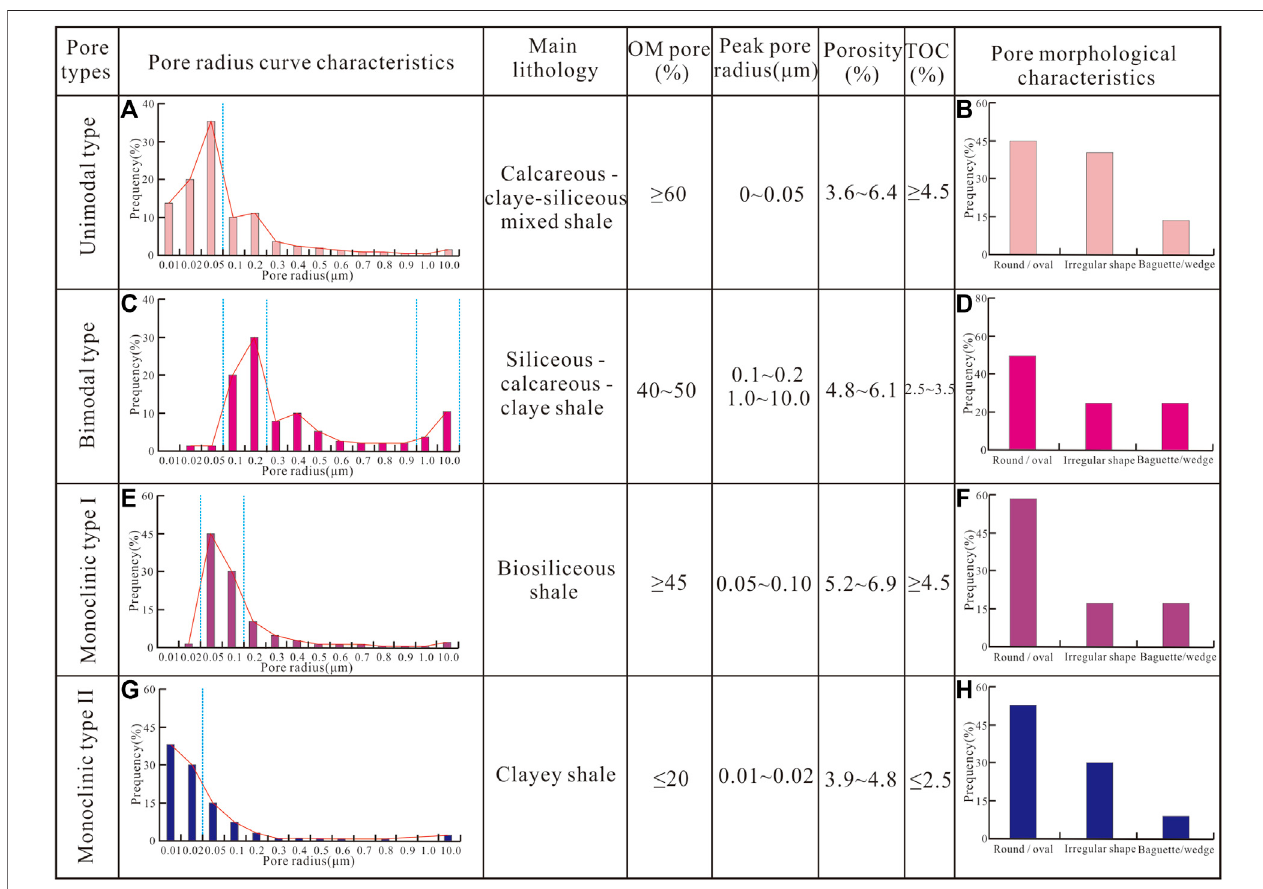
FIGURE 6 | Distribution characteristics of pore structure based on the SEM. (A) Pore radius curve characteristics of the unimodal type. (B) Pore morphological characteristicsoftheunimodaltype. (C) Poreradiuscurvecharacteristicsofthebimodaltype. (D) Poremorphologicalcharacteristicsofthebimodaltype. (E) Poreradius curvecharacteristics ofthe monoclinic type I. (F) Poremorphologicalcharacteristics ofthemonoclinictype I. (G) Poreradius curve characteristicsofthe monoclinic type II. (H) Pore morphological characteristics of the monoclinic type II.